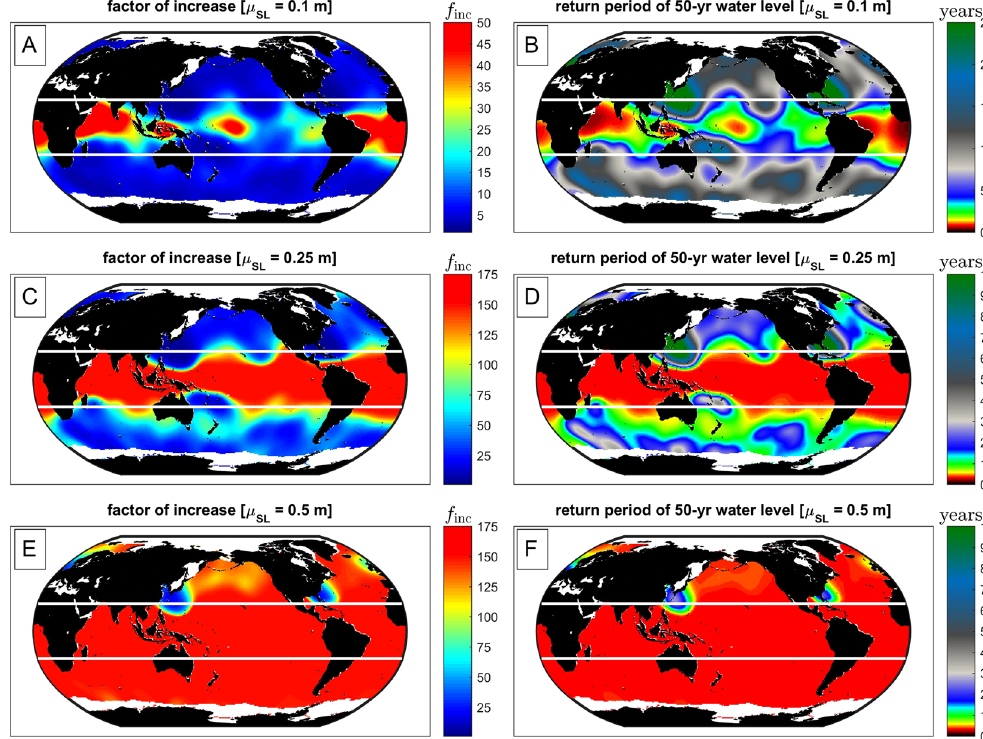
Figure 4. Global estimates of the expected factor of increase in exceedance probability, f inc , and the future return period, T R , of the 50-yr water level, for SLR projections: μ SL = + 0.1, + 0.25, + 0.5 m. We note that the estimated increase in flooding potential is purely due to SLR and not due to changes in climate or storminess. White lines indicate the Tropic of Cancer and Tropic of Capricorn. The maps in this figure were made using Matlab 2016a